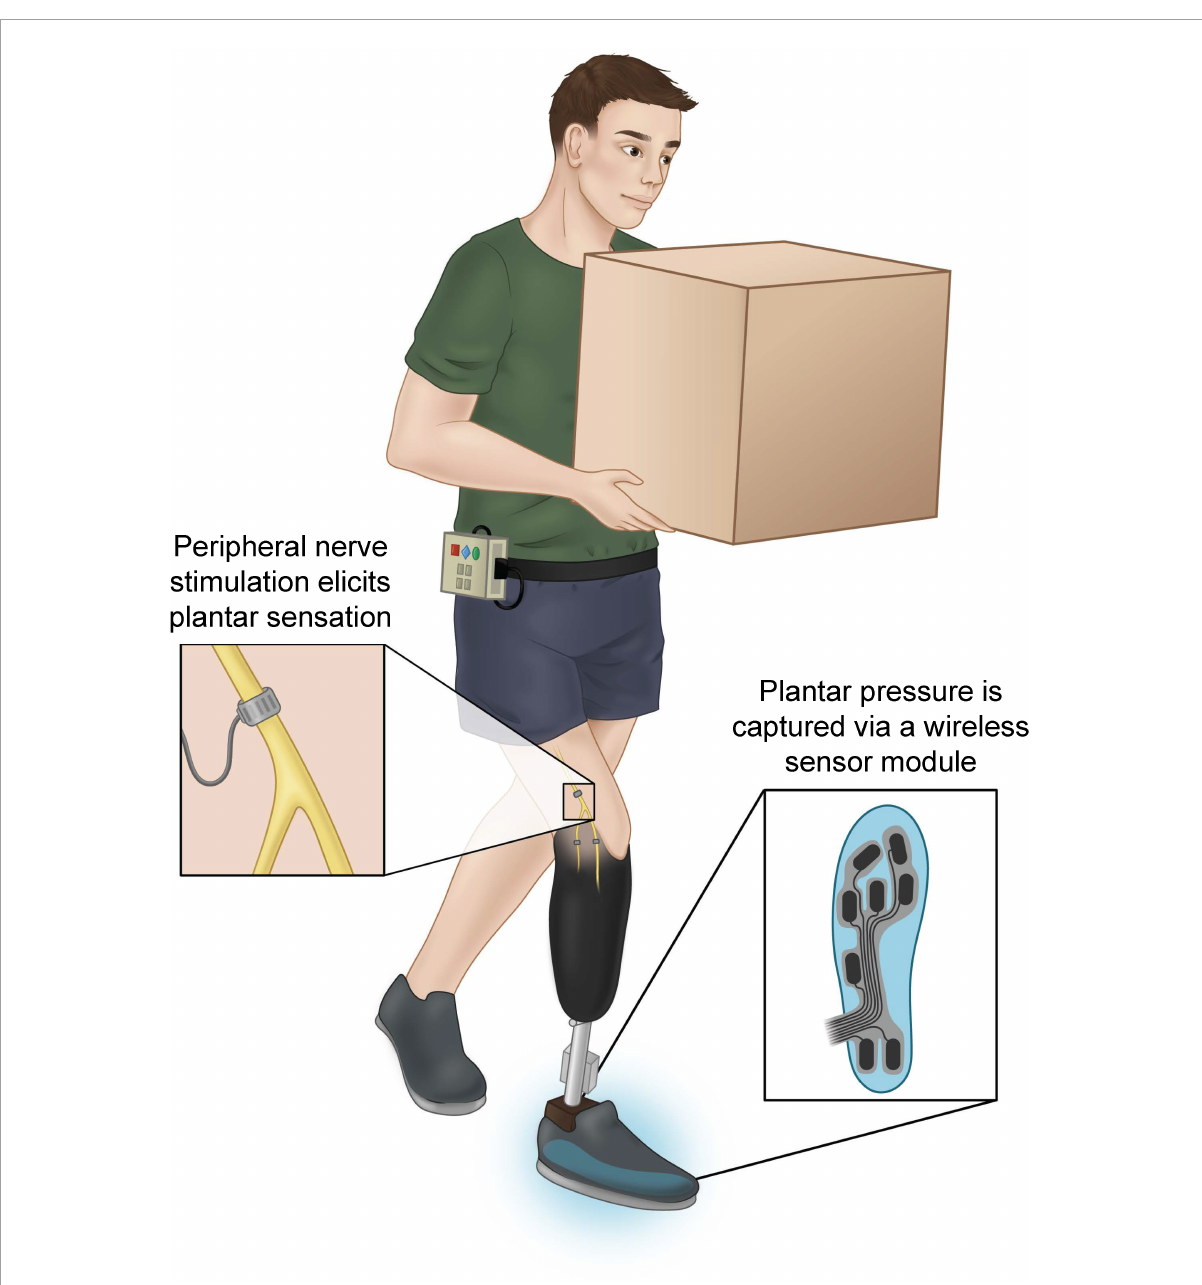
FIGURE1 Participant with unilateral transtibial limb loss using the sensory neuroprosthesis (SNP) to perform a task in which his vision is occluded. Sensors in his prosthesis shoe (right inset) transduce pressures applied to the prosthetic foot during walking, standing, or other activities. Sensor signals are sent wirelessly to an external neurostimulation system worn on the belt, which then sends neural stimulation to the sciatic and tibial nerves through chronically-implanted Composite Flat Interface Nerve Electrodes (C-FINEs) (left inset) .